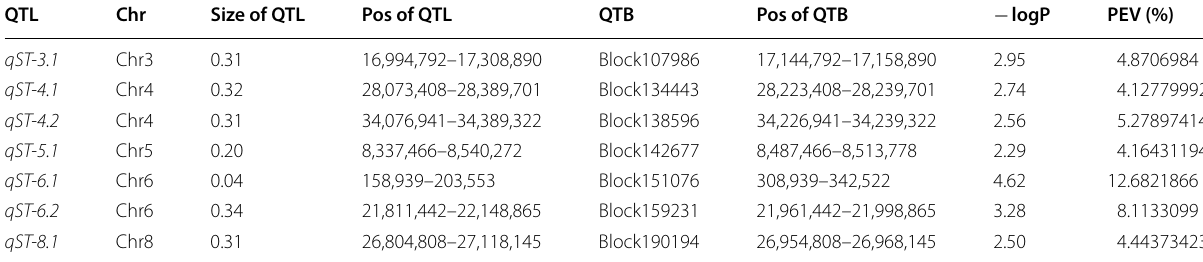
Table 1 Details of QTLs and QTBs from RTM-GWAS